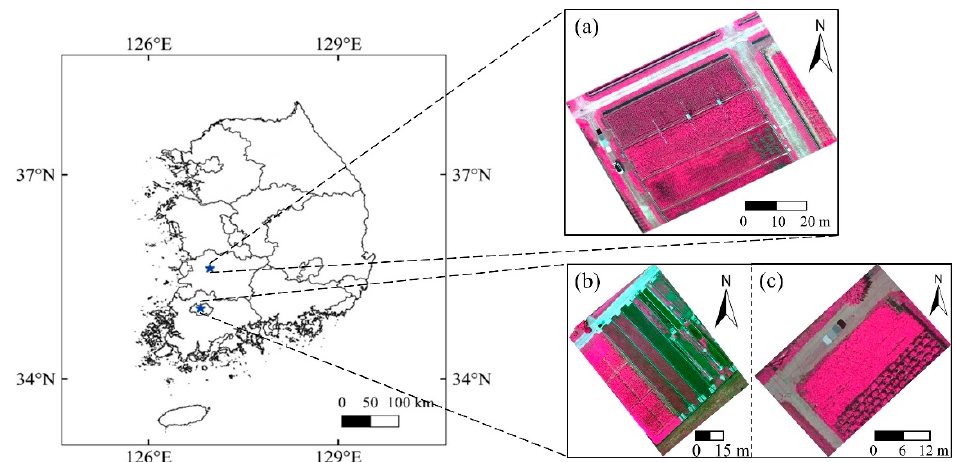
Figure 4. Location map and pseudo-colored aerial photographs of ( a ) paddy rice fields at the National Institute of Crop Science, Wanju, Chonbuk Province and ( b ) paddy rice and ( c ) soybean fields at Chonnam National University, Gwangju, Republic of Korea. The pseudo-colored aerial images were projected using green, red, and near-infrared wavebands obtained using a Micro agricultural digital camera (Tetracam Inc., Chatsworth, CA, USA).